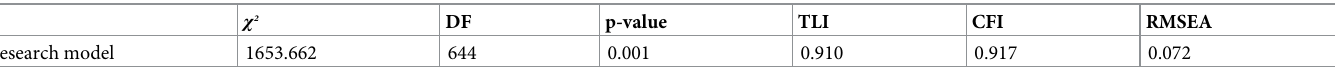
Table 5. Research model verification (N = 570).